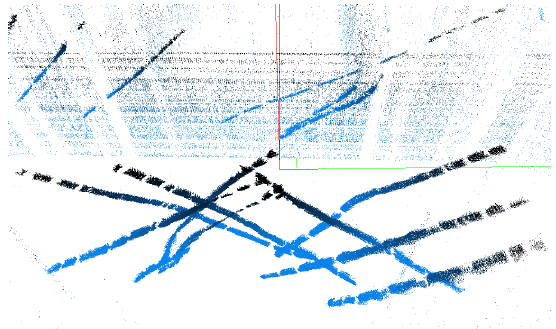
Figure 4: Detected moving objects shown in space-time coordi- nate system where ( x, y, t ) are in green, blue, red respectively. Dense point clusters are moving trajectories, and sparse points are false detections on street fences. Points are coloured from blue to black over time.